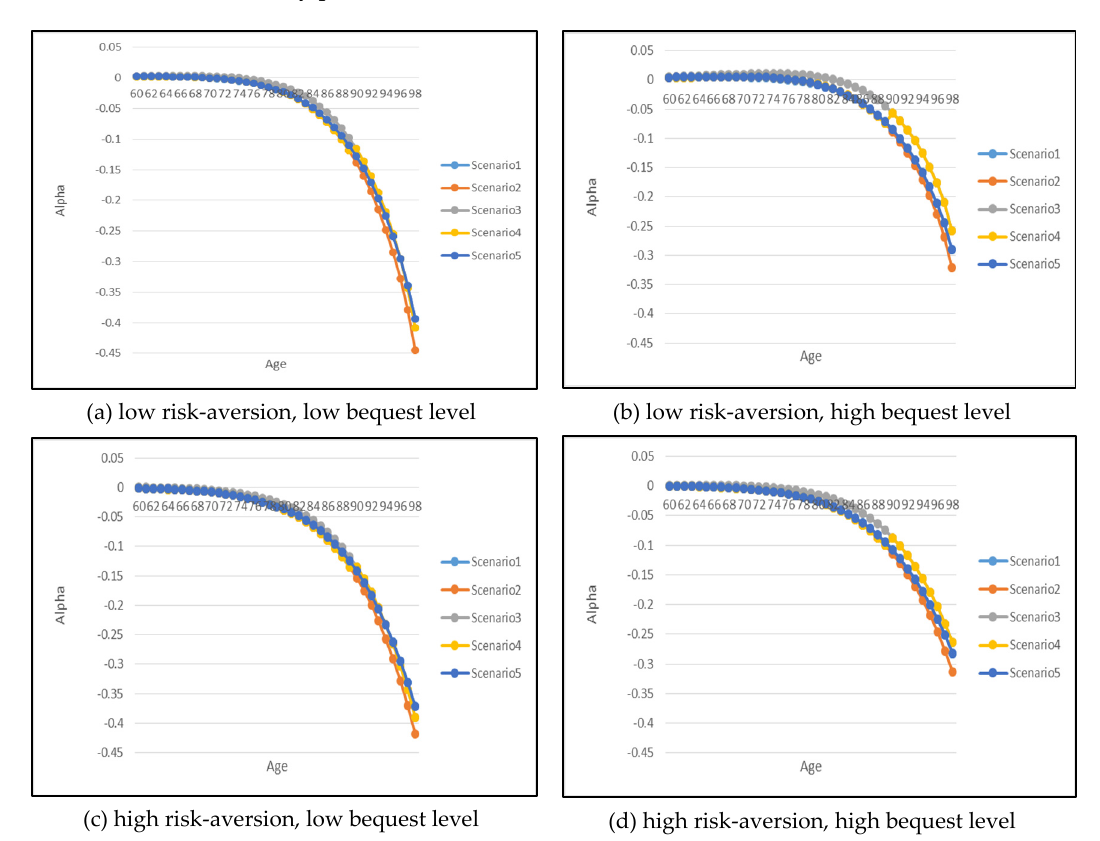
Figure 10. Optimal Annuity/Insurance Purchase for Males (Health-Dependent Utility).